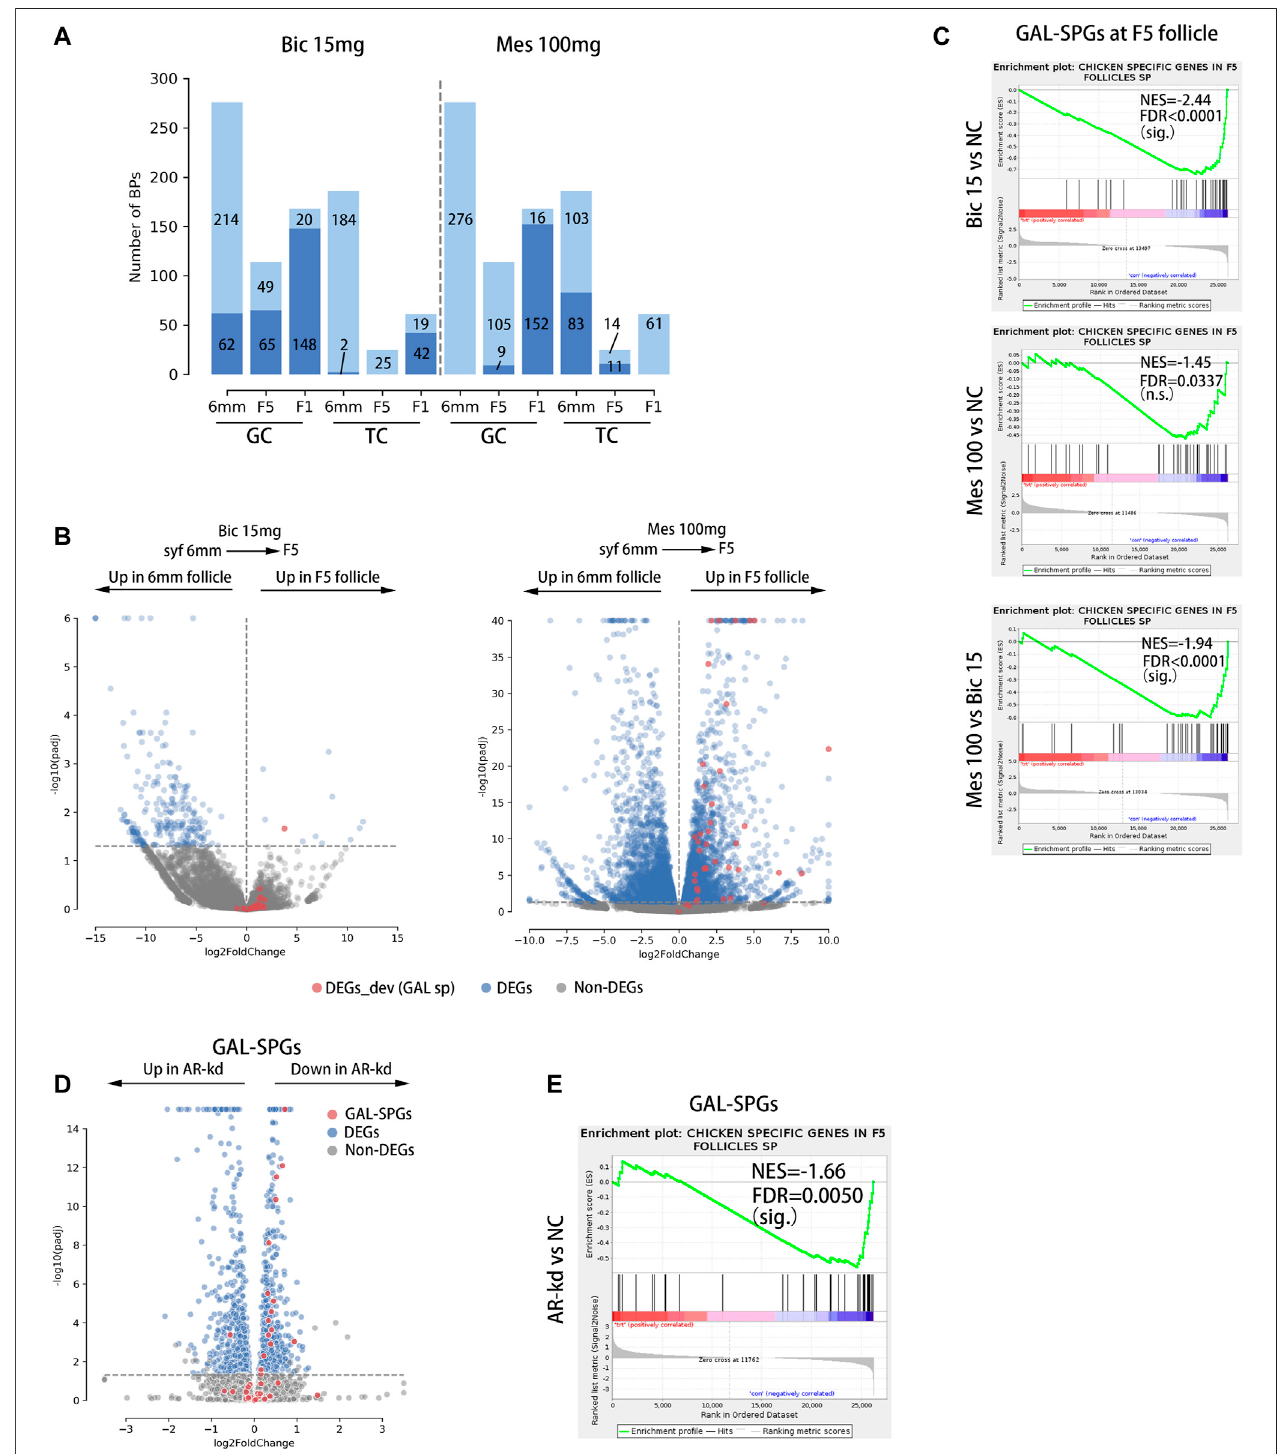
FIGURE 6 | GAL-SPGs are essential for follicle selection in chickens. (A) Stacked bar plot showing the distribution of follicle development-related BPs that are signi fi cantly altered by inhibiting or enhancing the function of androgen receptors, which are in deep blue. The follicle development-related BPs that are not signi fi cantly altered by inhibiting or enhancing the function of androgen receptors are in light blue. The number of BPs in each group is labelled. (B) Volcano plot showing the differential expression ofGAL-SPGs(red) before and after follicle selection (syf 6 mm vs F5)when ARfunction isinhibited (bic 15 mg, left ofthe graph) or enhanced (mes100 mg,rightofthegraph).Differentiallyexpressedgenes(FPKM ≥ 1andPadj ≤ 0.05)aremarkedinblue. (C) TheGSEAresultsshowingtheconsistentdifferences